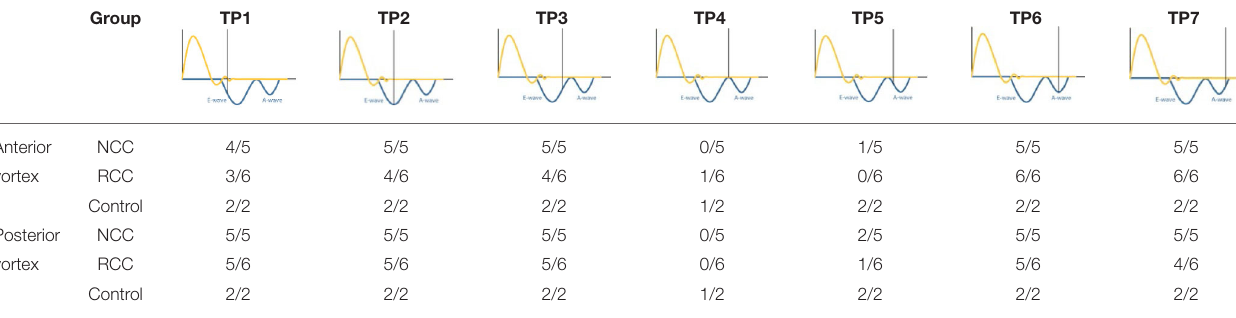
TABLE 2 | Presence of anterior and posterior vortex for each time point (TP) at the site of PVL jet